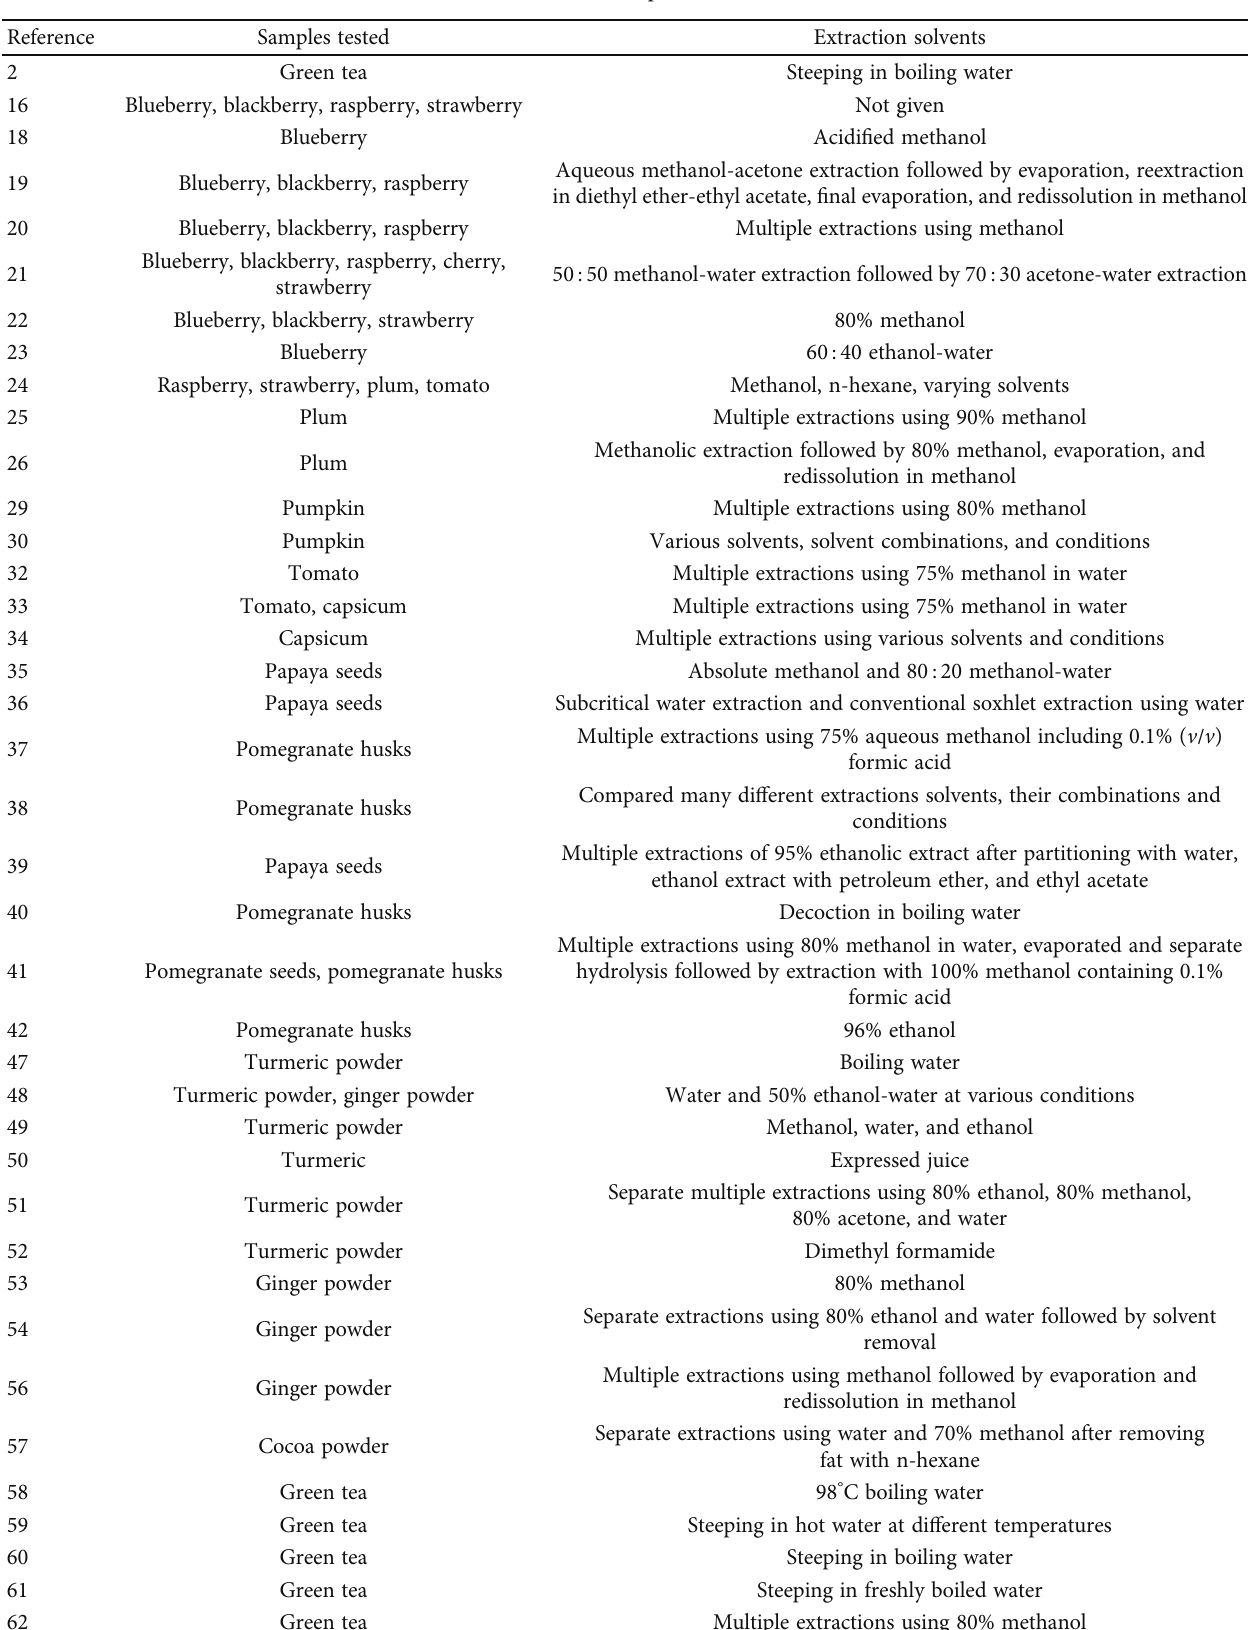
Table 1: Extraction solvents as presented in the